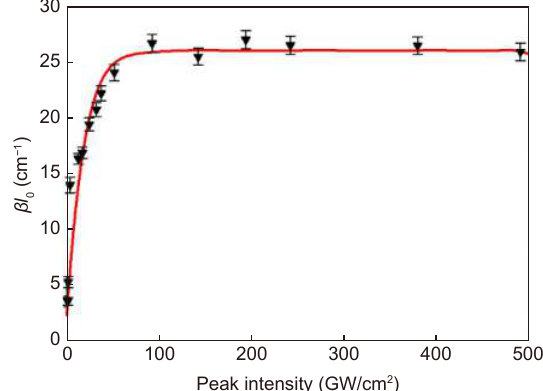
Fig. 11 | Effective NL absorption coefficient βI 0 (cm –1 ) based on the data of Fig. 5(b)/Fig. 6(b) which drops significantly at lower intensity, increasing the coupling depth for 2-photon excitation. βI 0 converges to ~ 26 cm –1 above 100 GW cm –2 . These values are consistent with observed side fluorescence (Fig. 10).